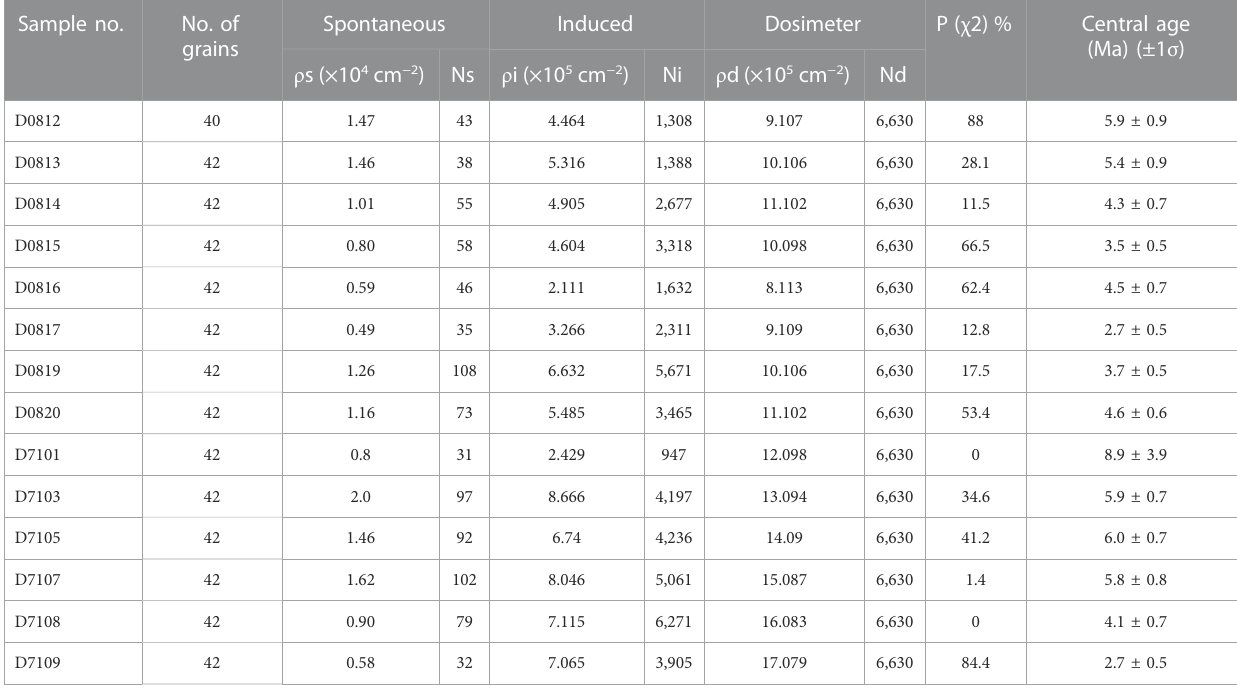
TABLE 2 Apatite fi ssion track results from the Kangmar dome. Sample no. No. of